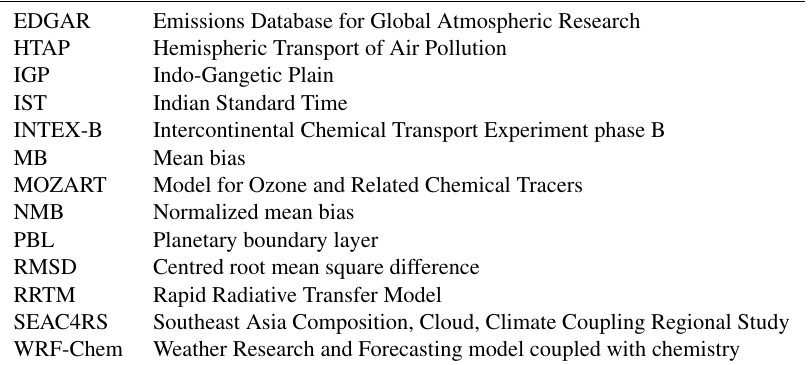
Table 1. Abbreviations and